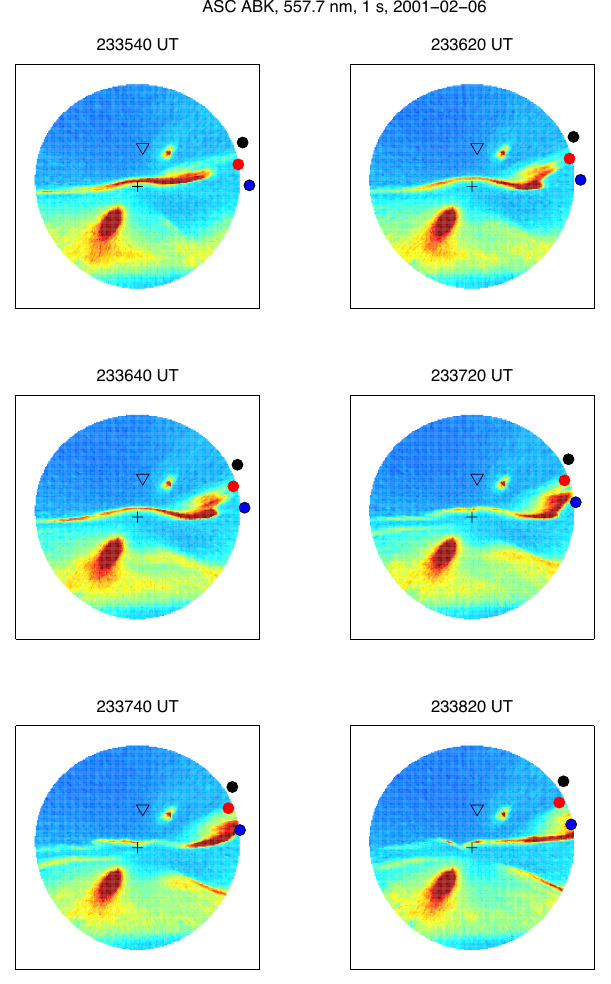
Fig. 8. As Fig. 2, but for ABK and the poleward arc.